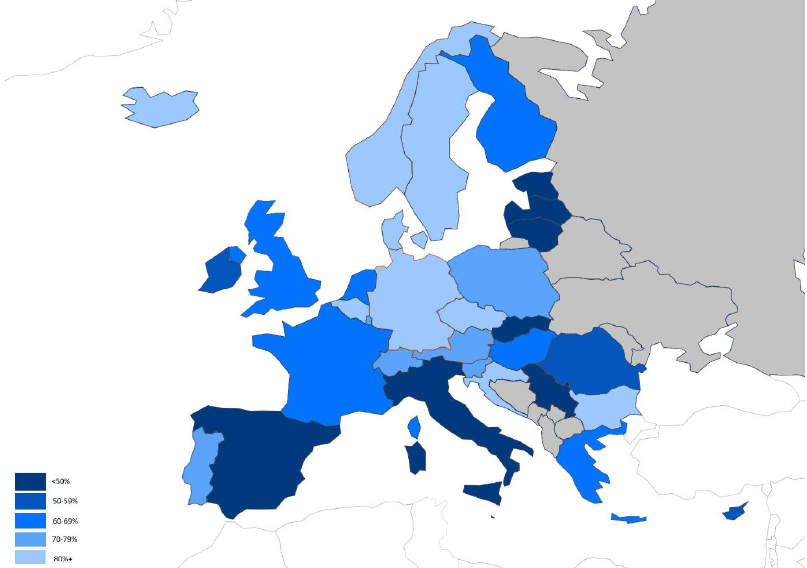
Figure 2. Proportion of households that are satisfied with the offer of formal childcare for their children aged 12 or below across 32 European countries (2016). Satisfaction is defined as not using more of the offer because they have no need of it, as opposed to, for example, because of financial reasons, lack of available places, not suitable opening hours, low quality of service, or inconvenient distance from household. Source: ref